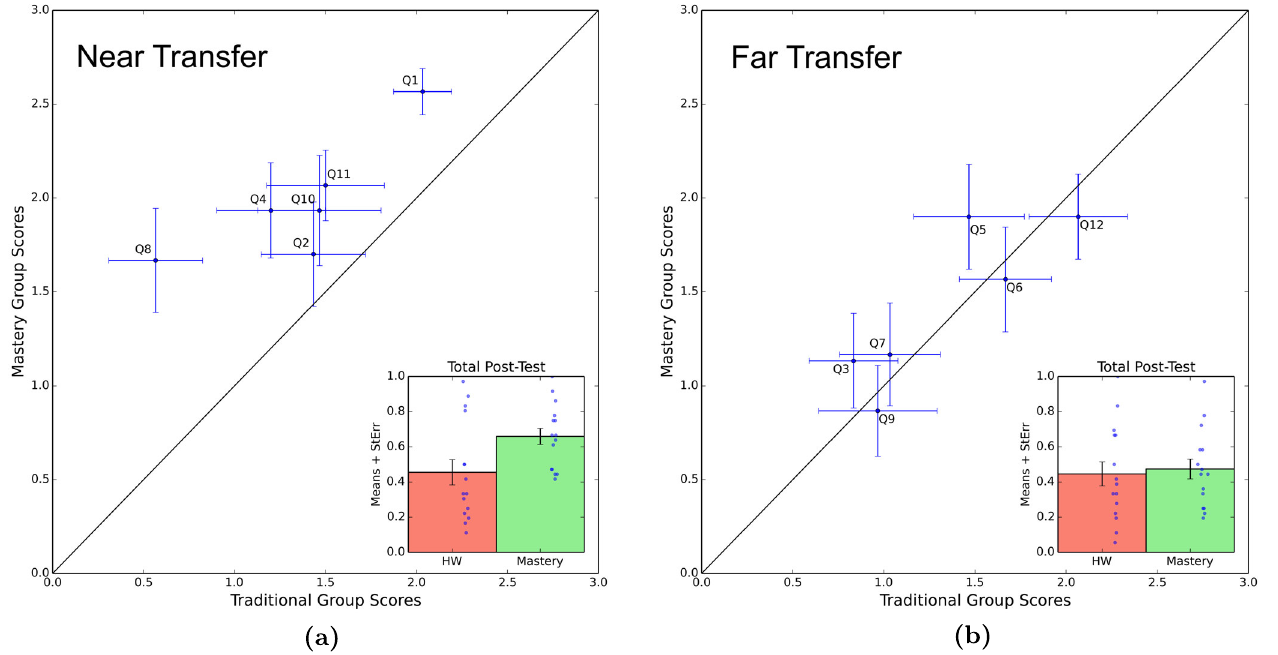
FIG. 2. Performance of students in the first clinical trial, with nearer- and farther-transfer questions analyzed separately. (a) Performance of students on those post-test questions which were judged to be nearer-transfer to the homework problems. As seen on the inset graph, the difference in total scores between the mastery and traditional homework groups was judged to be significant with p ¼ 0 . 009 ( p ¼ 0 . 018 two-tail t -test) and a Cohen ’ s d effect size of 0.9. (b) Performance of students on those post-test questions which were judged to be farther-transfer to the homework problems. As seen on the inset graph, the difference in total scores between the mastery and traditional homework groups was not